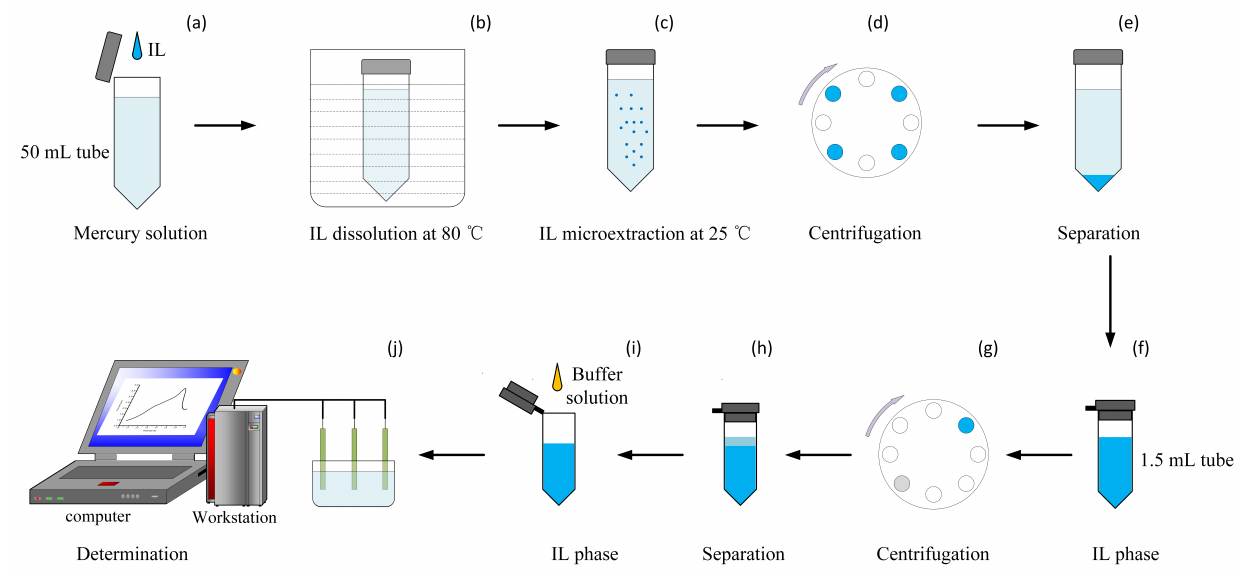
Figure 1. Graphical illustration of the detection of mercury. ( a , b ) The mercury dissolved IL achieving saturated IL aqueous solution at 80 ◦ C; ( c ) then temperature decreased to 25 ◦ C with IL droplets suspending in the emulsion. After ( d , e ) centrifugation and separation, ( f ) the IL was moved into a 1.5 mL tube. After ( g , h ) centrifugation and separation